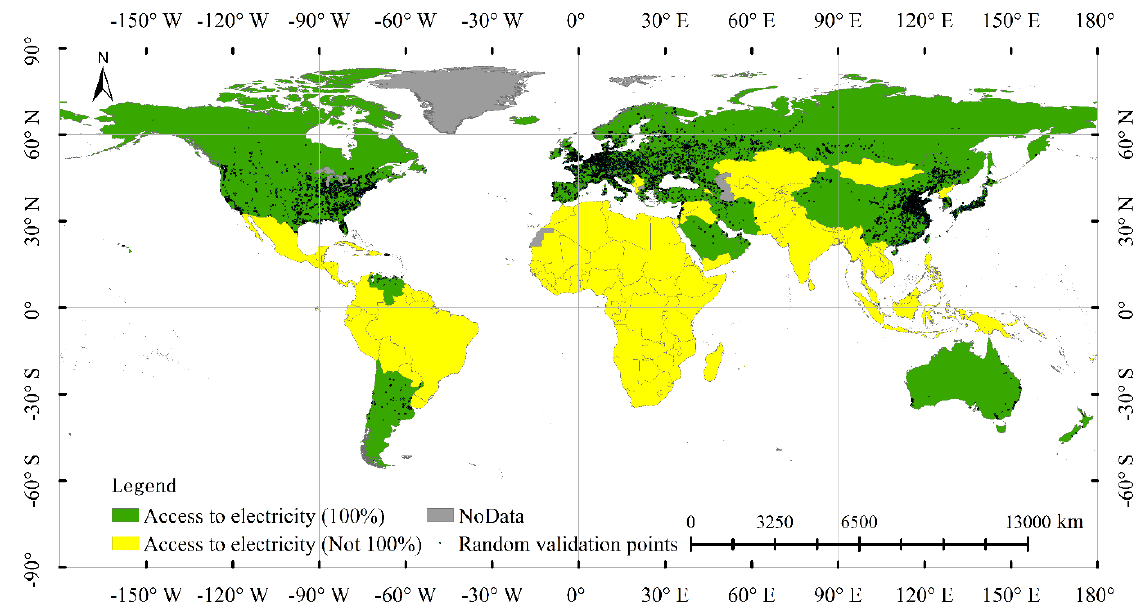
Figure 5. Distribution of validation sample points.